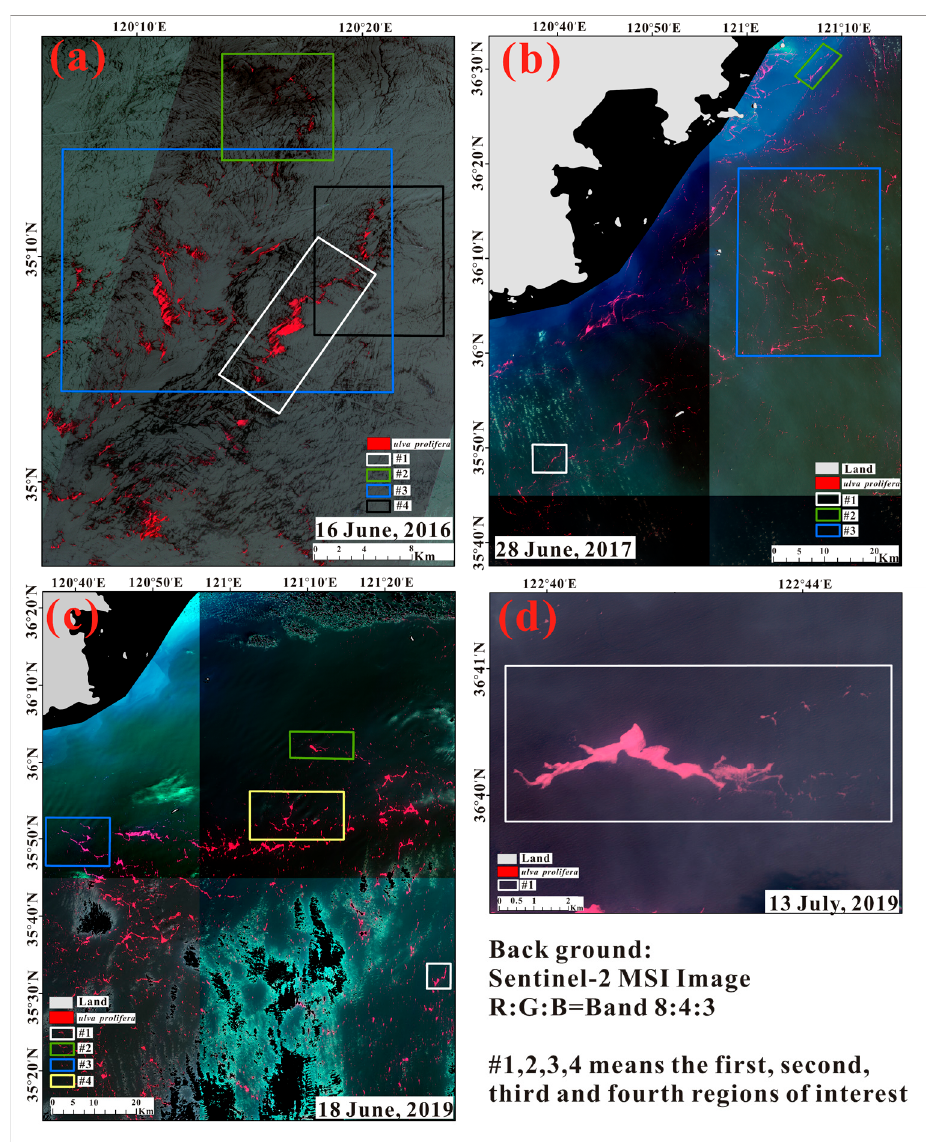
Figure 7. Map of regions of interest. ( a ) Distribution map of four ROI on 16 June 2016, ( b ) Distribution map of three ROI on 28 June 2017, ( c ) Distribution map of four ROI on 18 June 2019, ( d ) A distribution map of one ROI on 13 July 2019.